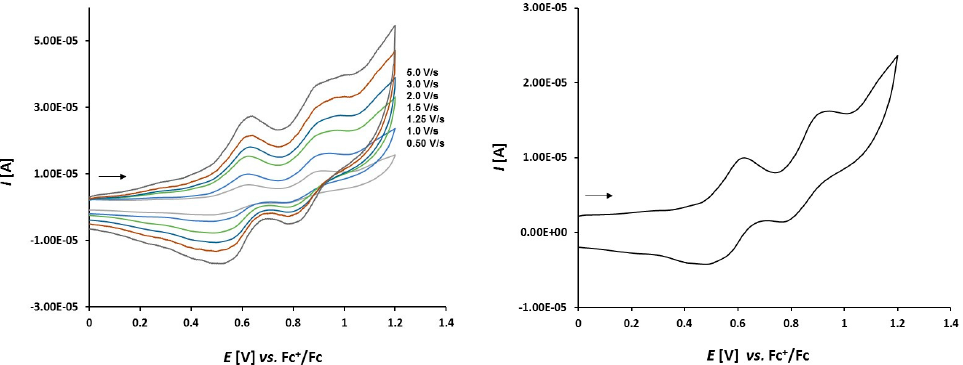
Figure 9. Cyclic voltammetry of complex 3b (1.0 mmol/L) in CH 2 Cl 2 -[ n Bu 4 N][BF 4 ] (0.1 m/L) solutions at various scan rates ( left ) and at v = 1.0 V/s ( right ). The potentials E are given in V and referenced to the Fc + /Fc couple. The arrows indicate the scan direction.